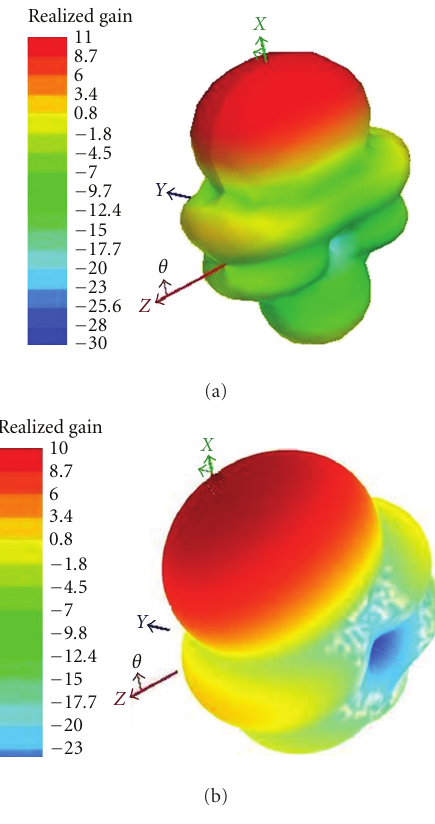
Figure 13: Simulated (a) and measured (b) 3D radiation pattern of the dipole antenna with reflector and 4 directors.